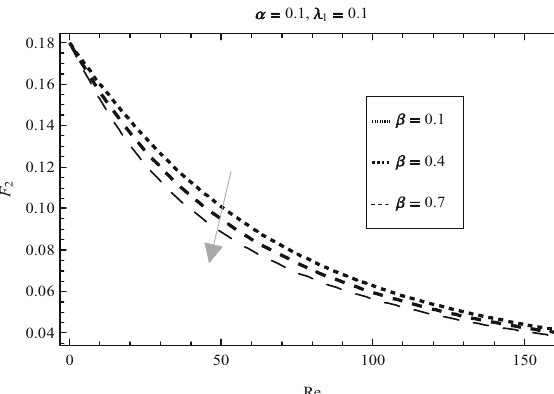
Fig. 22 Variation of F 2 along Re for different values of β